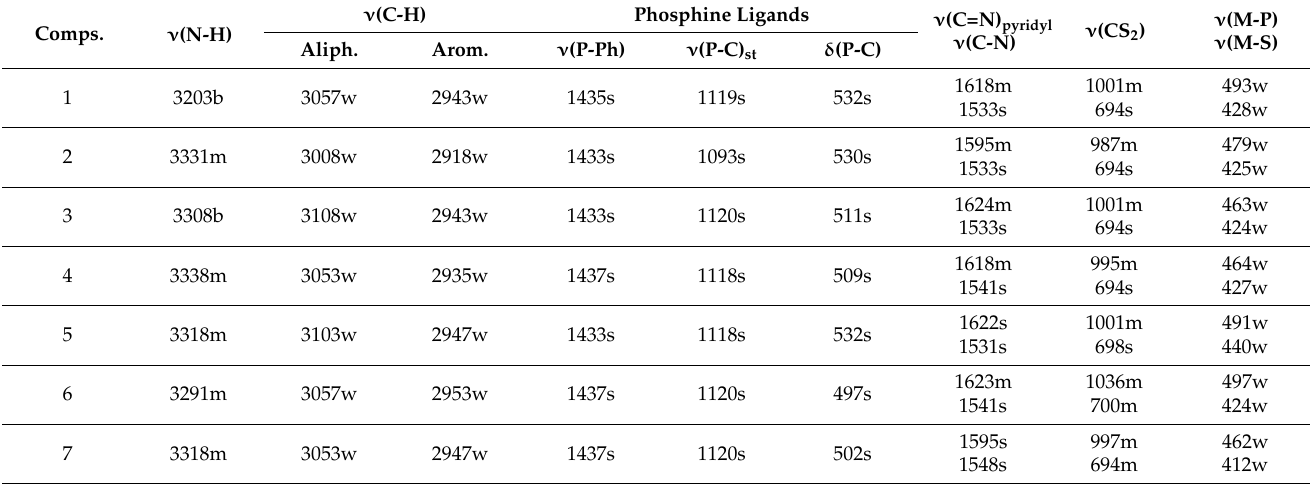
Table 3. IR data of the synthesized complexes in (cm − 1